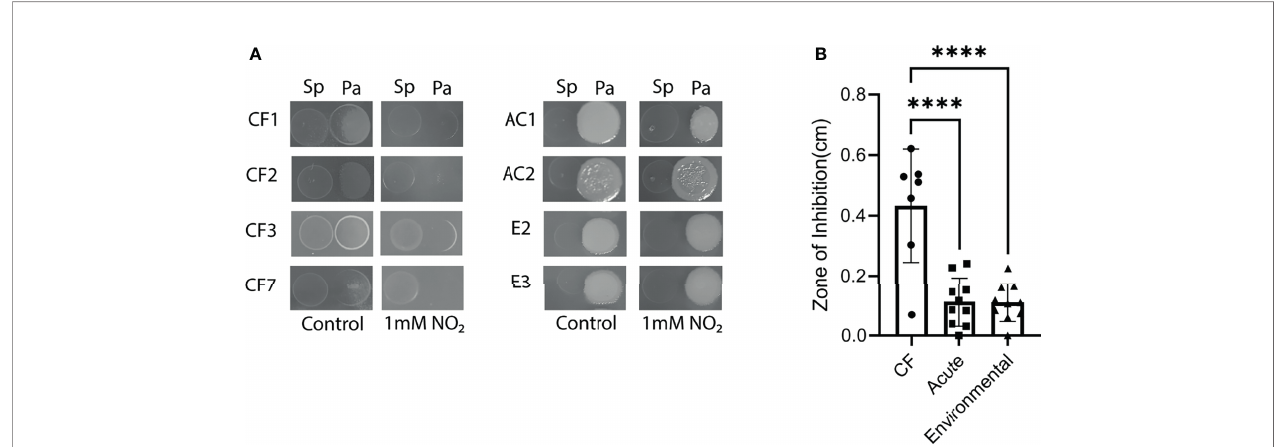
FIGURE 4 | Clinical CF isolates of P. aeruginosa are sensitive to S. parasanguinis- induced nitrosative stress. (A) Representative clinical, acute, and environmental isolates of P. aeruginosa were spotted next to S. parasanguinis in the presence or absence of 1mM nitrite. (B) Average zone of inhibition for each isolate was calculated. Isolates were grouped into CF isolates, acute isolates, or environmental isolates. Zones of inhibition of each group were compared. CF, n=7; Acute, n=10; Environmental, n=10. Error bars represent standard deviation, ****P < 0.0001 (Kruskal-Wallis, Dunnett Post Hoc